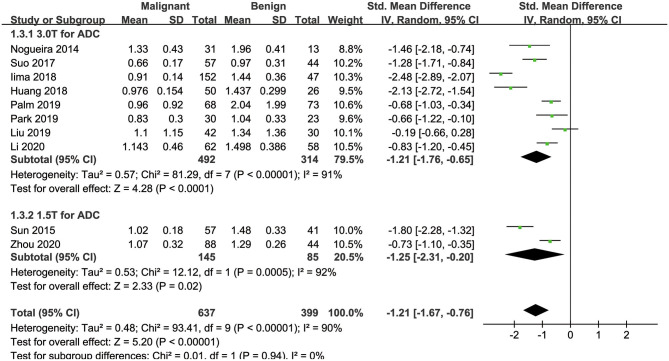
Forest plot of the mean value of the apparent diffusion coefficient (ADC) between malignant and benign breast lesions. The standardized mean differences indicated that breast cancers had a significantly lower ADC than benign lesions.